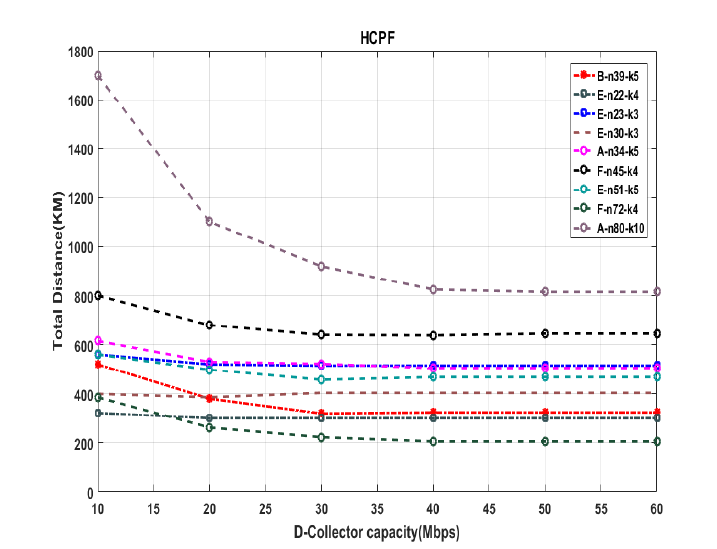
Figure 11. D-collector capacity vs. total distance